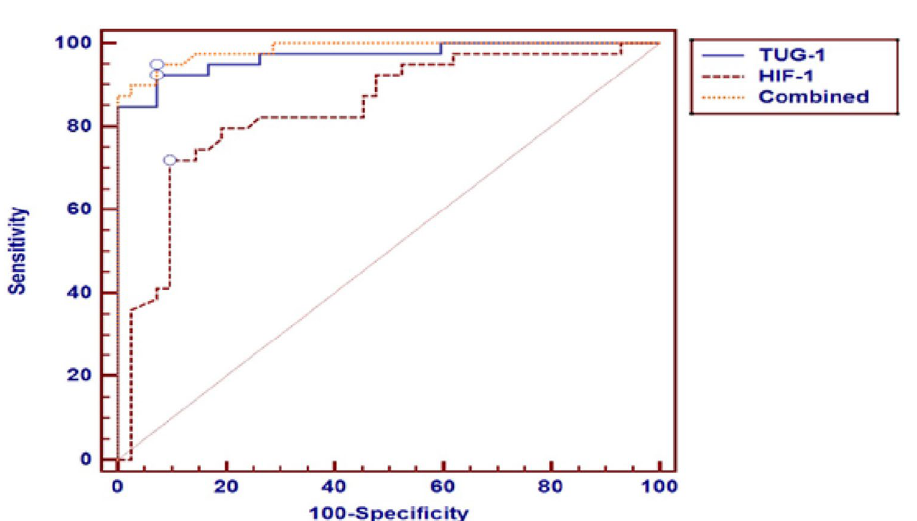
Figure 5. ROC for the best cut off point between TMX‑sensitive and TMX‑resistant groups regarding TUG‑1 and HIF‑1α. ROC curve was used to assess the best cut off point for predictors of mortality with its sensitivity, specificity, positive predictive value, negative predictive value and area under curve. Logistic regression analysis (univariate and multivariate) was used to assess the association between symptoms and different parameters with its odds ratio and 95% CI. This figure was constructed for multivariate significance in order to establish an experimental model for our study (with 88.3% sensitivity and 91.6% specificity), where BC patients with TUG‑1 value > 63.77 and HIF‑1α value < 1.46 can be considered resistant to TMX